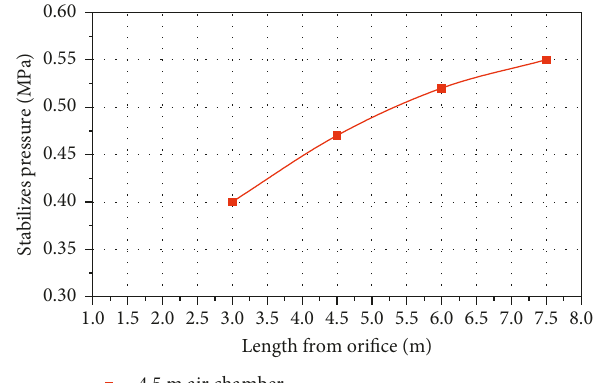
Figure 8: A diagram of the steady pressure change in the 4.5 m gas chamber.